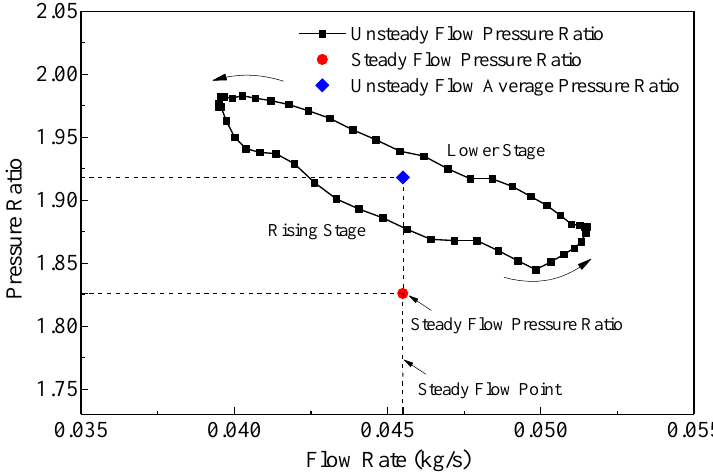
Figure 10. Distribution of pressure ratio characteristics at 150,000 rpm. Table 5. Comparison of the unsteady flow energy of the original compressor at the joint point with the steady flow value at 150,000 rpm.